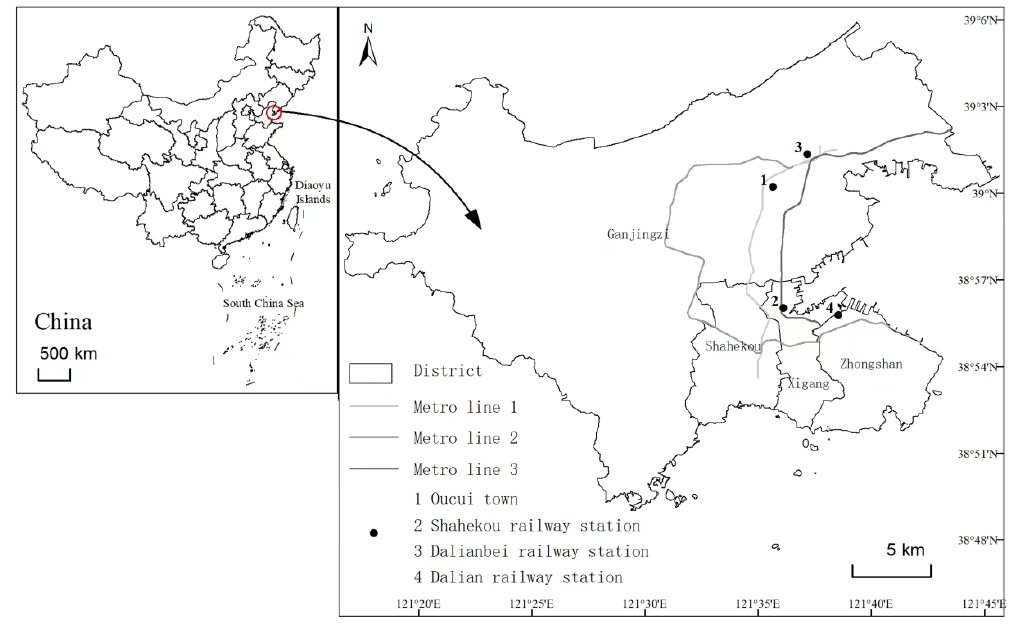
Figure 1. Study area location. Table 1. Public service facilities by